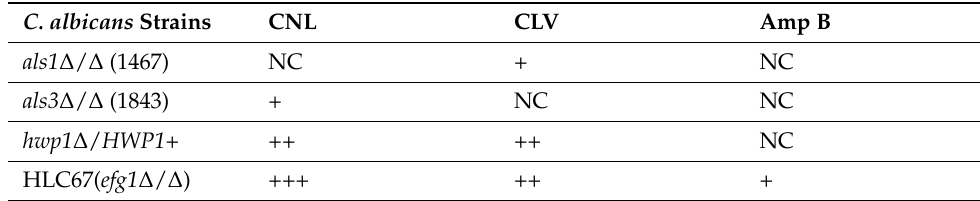
Table 4. Sensitivity of C. albicans SC5314, als1 ∆ / ∆ , als3 ∆ / ∆ , hwp1 ∆ / HWP1 + and HLC67( efg1 ∆ / ∆ ) to EOs and Amp